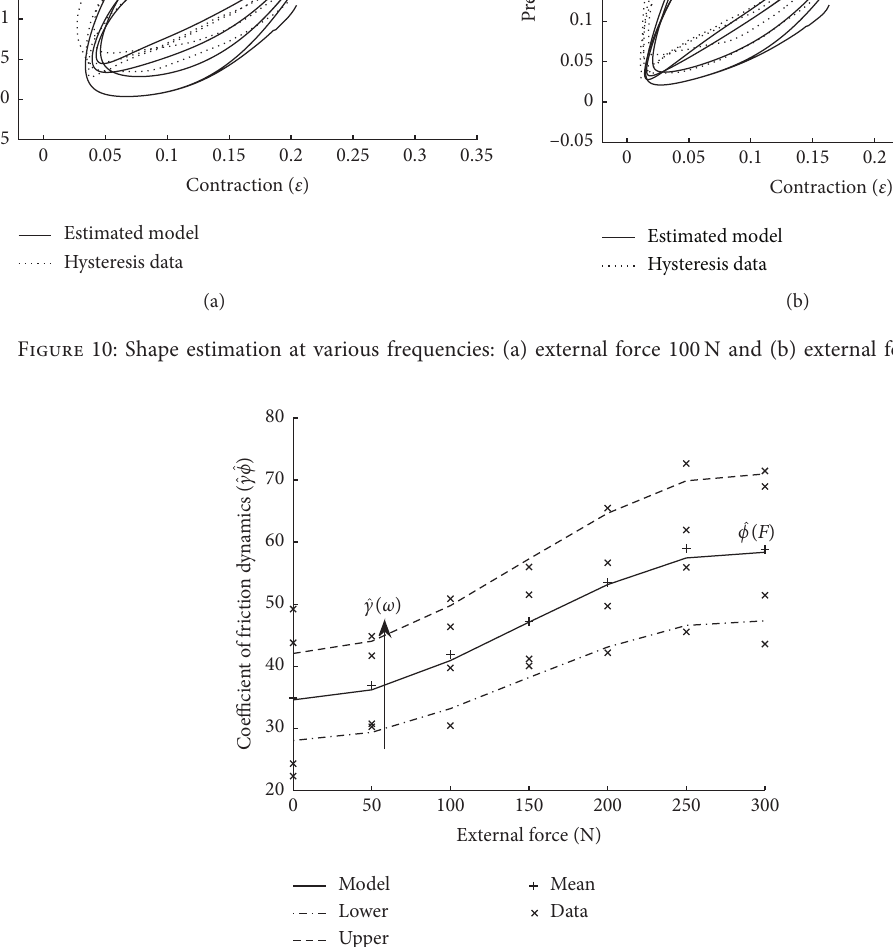
Figure 11: Regression of dynamic friction coefficients.